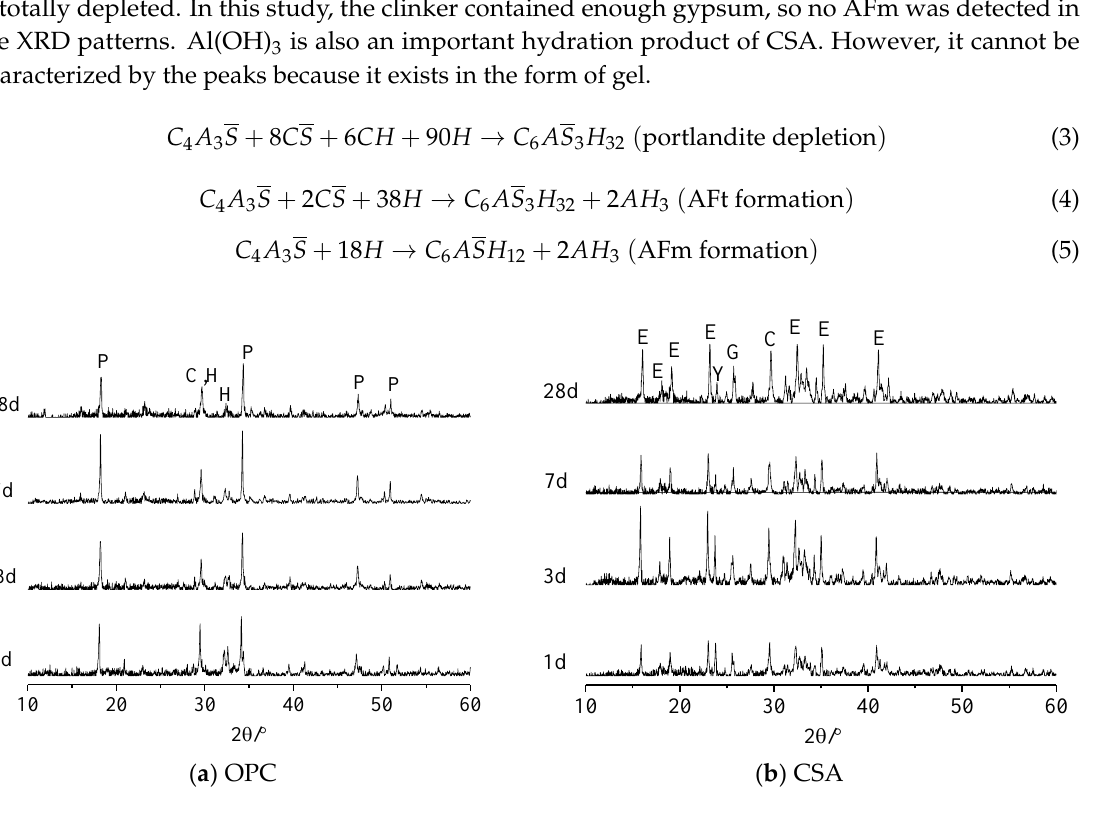
Figure 3. X-ray diffraction patterns of ( a ) OPC and ( b ) CSA. (C: carbonate, E: ettringite, G: gypsum, H: C-S-H, P: portlandite, Y: yeelimite).